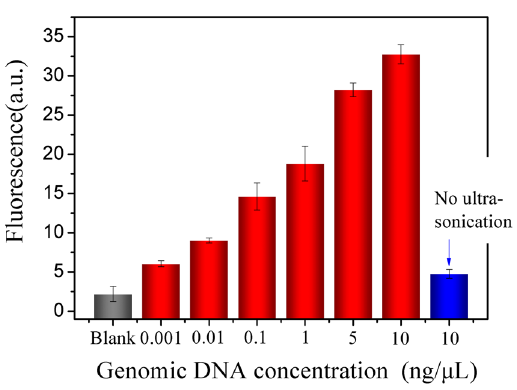
Figure 7. Detection of C . neoformans genomic DNA by